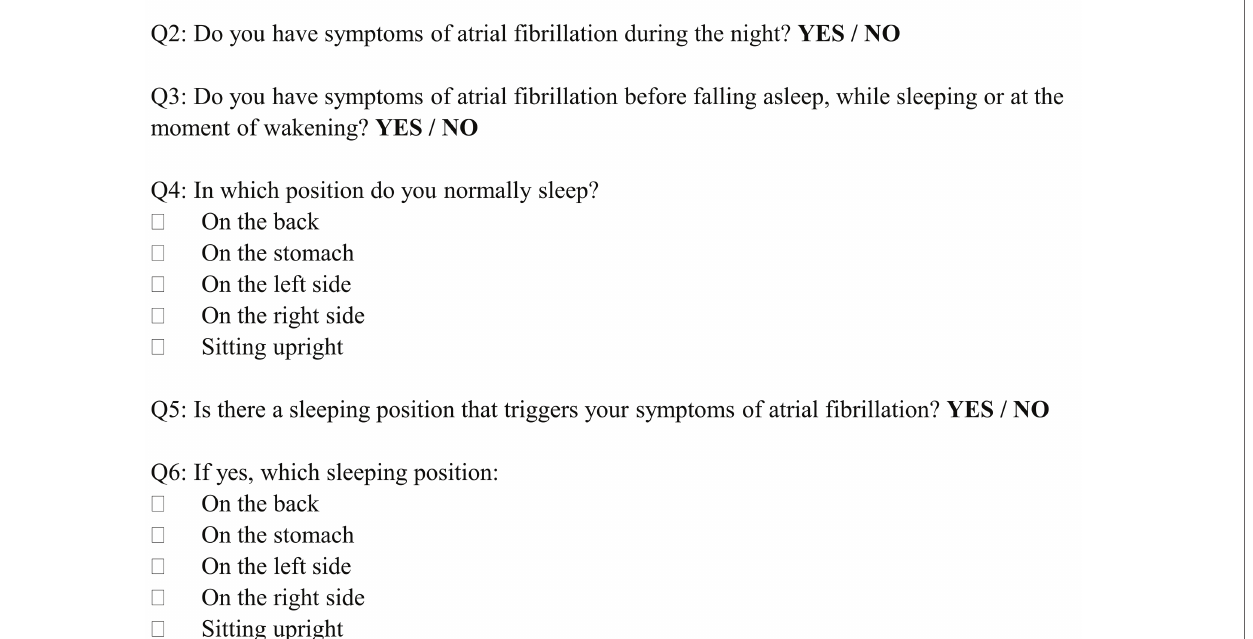
FIGURE 1 | Questionnaire. A 1-page questionnaire was handed out to drug-resistant paroxysmal AF patients admitted to a tertiary center before elective ablation